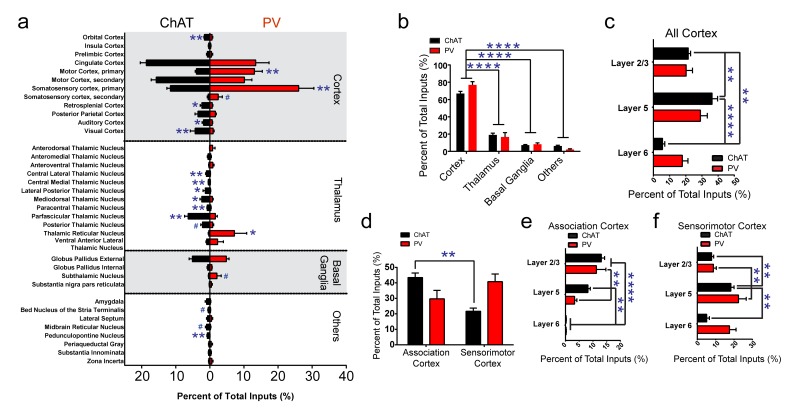
Summary of brain-wide direct inputs to striatal ChAT and PV interneurons.(a) Major input regions (>0.4% of total inputs) to ChAT (black bar) and PV (red bar) interneurons. A complete set of all inputs to ChAT and PV interneurons is shown in Figure 2—figure supplement 1. (b) ChAT and PV interneurons receive predominately cortical innervation (two-way ANOVA, F(3,36) = 325.1, p<0.0001). (c) Cortical laminar distribution of all inputs to ChAT and PV interneurons. ChAT interneurons receive a significant bulk of inputs from layer five compared to other cortical layers (two-way ANOVA, Sidak’s, 5 vs. 6, p<0.0001; 2/3 vs. 6, p=0.0019; 2/3 vs. 5, p=0.0041). (d) Sorted association and sensorimotor cortex inputs to ChAT and PV interneurons (see Materials and methods). ChAT interneurons receive a greater percentage of associative versus sensorimotor inputs (two-way ANOVA, Sidak’s, p=0.0001). (e) Association cortex laminar distribution is biased to superficial layers. ChAT interneurons receive more associative layer 2/3 than layer six projections and more layer 5 than six projections (two-way ANOVA, Sidak’s, layer 2/3 vs. 6, p<0.0001, layer 5 vs. 6, p=0.0012). PV interneurons also receive more associative layer 2/3 than layer 5 and 6 projections (two-way ANOVA, Sidak’s, layer 2/3 vs. 6, p<0.0001, layer 2/3 vs 5, p=0.0029). (f) Sensorimotor cortex laminar distribution is biased to deep layers. ChAT interneurons receive more sensorimotor layer five projections than layer 2/3 or layer six projections (two-way ANOVA, Sidak’s, layer 5 vs. 6, p=0.0010, layer 2/3 vs. 5, p=0.0086). PV interneurons receive more sensorimotor layer 5 than layer 2/3 projections (two-way ANOVA, Sidak’s, layer 2/3 vs. 5, p=0.0018). All figures mean ± SEM. In blue, *p≤0.05, **p≤0.01, ****p≤0.0001, # p<0.08. The following figure supplements are available for Figure 2: Figure 2—figure supplements 1 and 2.